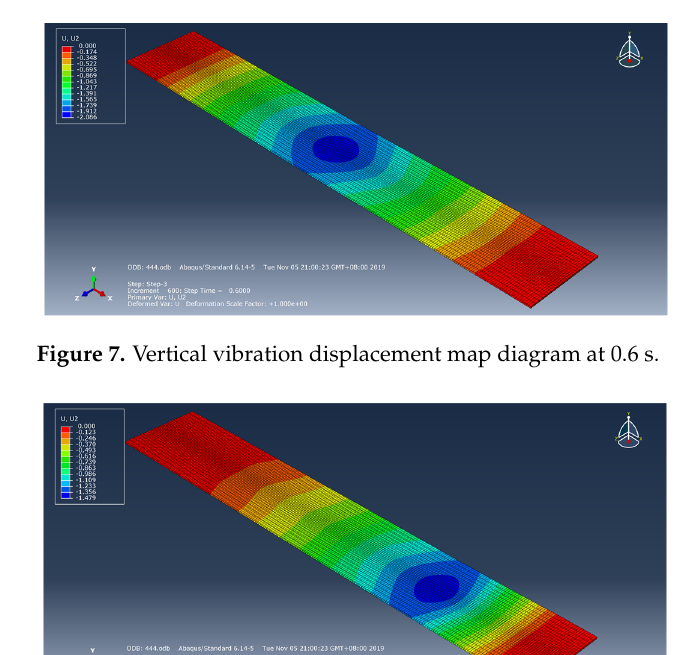
Figure 6. Vertical vibration displacement map diagram at 0.3 s.